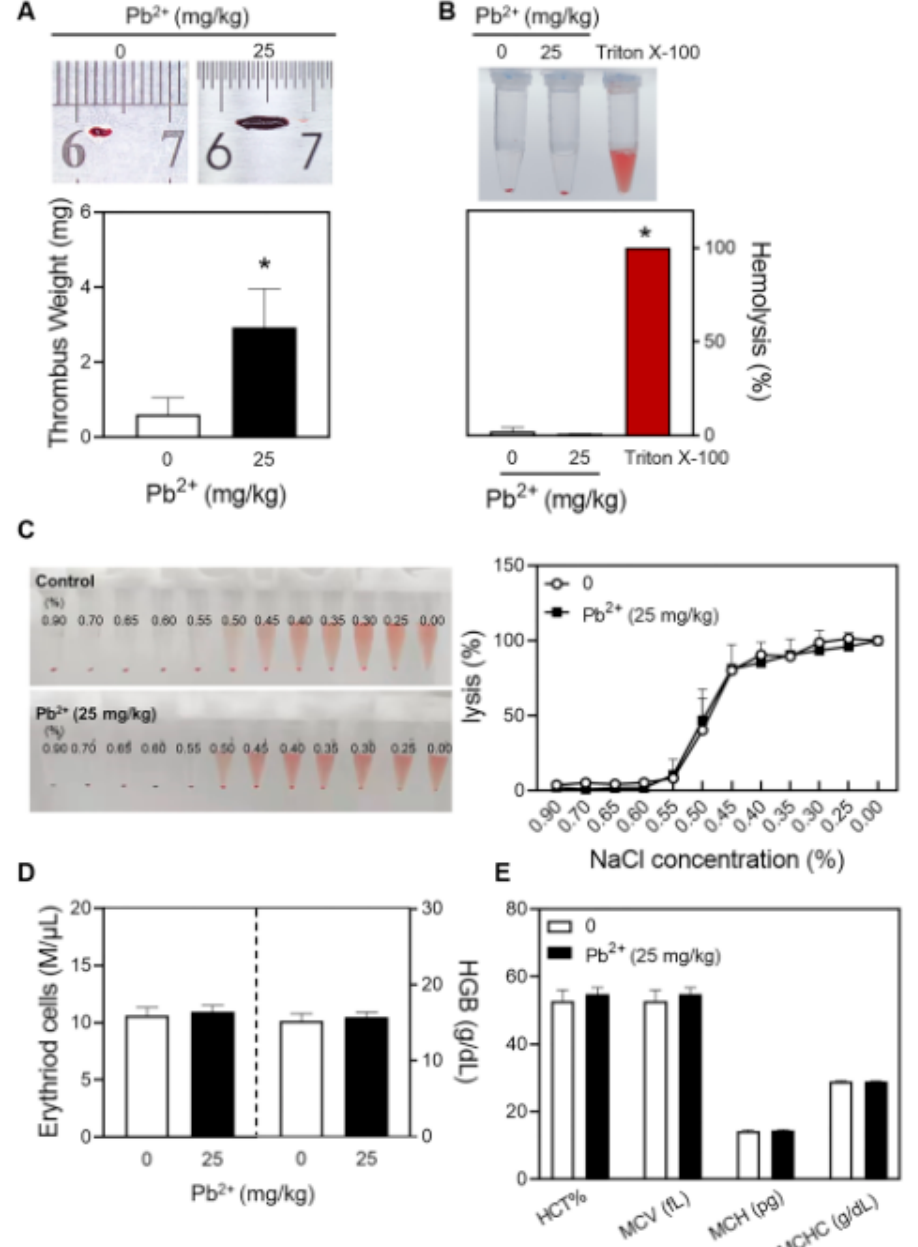
Figure 5. Pb can cause thrombus formation prior to hemolysis in mice. After 25 mg/kg Pb exposure to mice for 1 h was employed, ( A ) thrombus formation was observed and thrombus weight was determined. In addition, ( B ) in vivo hemolysis and ( C ) erythrocyte osmotic fragility (left, imaging data; right, percentage of lysis in different concentrations of NaCl) were performed. ( D ) The counts of erythroid cells and hemoglobin (HGB) content, ( E ) hematocrit percentage (HCT%), mean corpuscular volume (MCV), mean corpuscular hemoglobin (MCH) and mean corpuscular hemoglobin concentration (MCHC) were detected by using a hematology analyzer. Values are mean ± SD of 3–4 independent experiments, * Statistical difference compared with control ( p < 0.05).